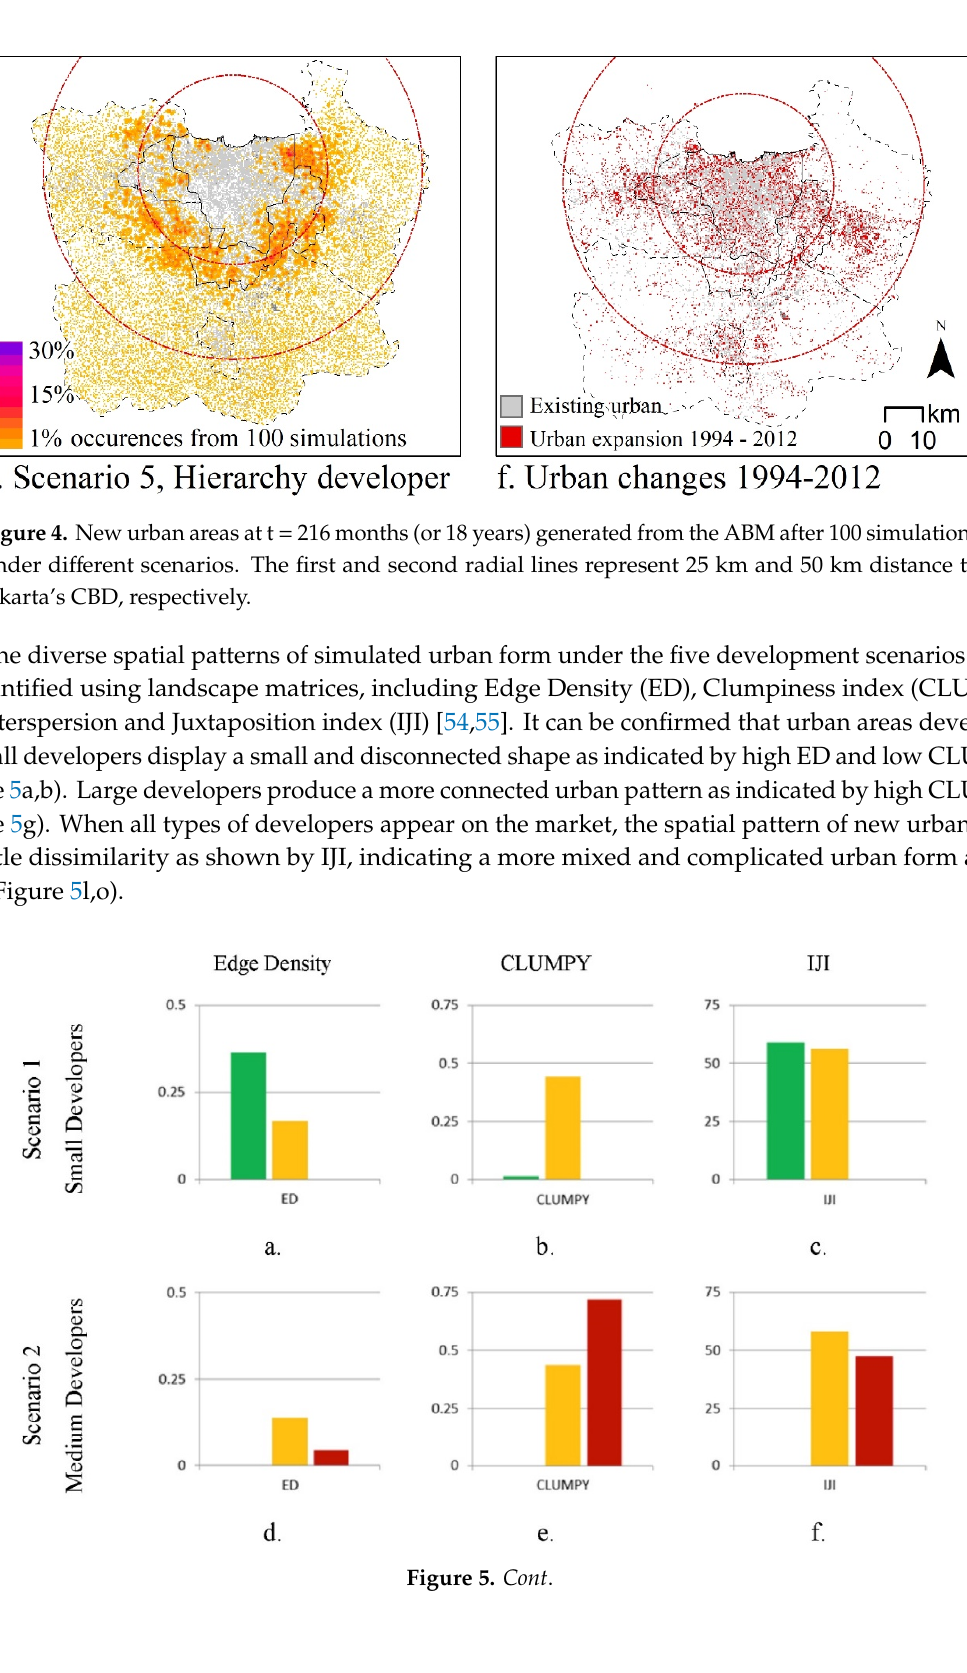
Figure 5. Landscape matrices under different scenarios.